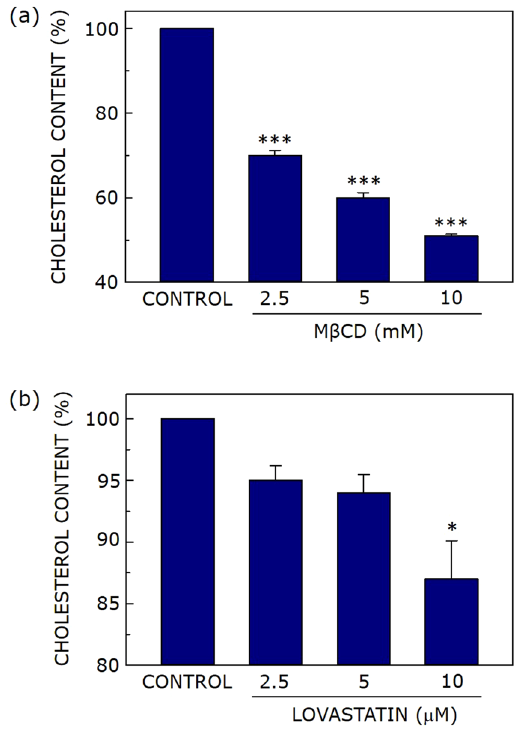
Figure 1. Membrane cholesterol depletion upon acute or chronic treatment. Effect of increasing concentration of ( a ) M β CD and ( b ) lovastatin on cholesterol content of CHO-K1 cell membranes. Values are expressed as percentage of cholesterol content for cell membranes in the absence of M β CD or lovastatin treatment. Data represent means ± S.E. of at least three independent measurements ( * and *** correspond to significant ( p < 0.05 and p < 0.001) difference in cholesterol content of M β CD or lovatstatin-treated cell membranes relative to untreated membranes). See Methods for other